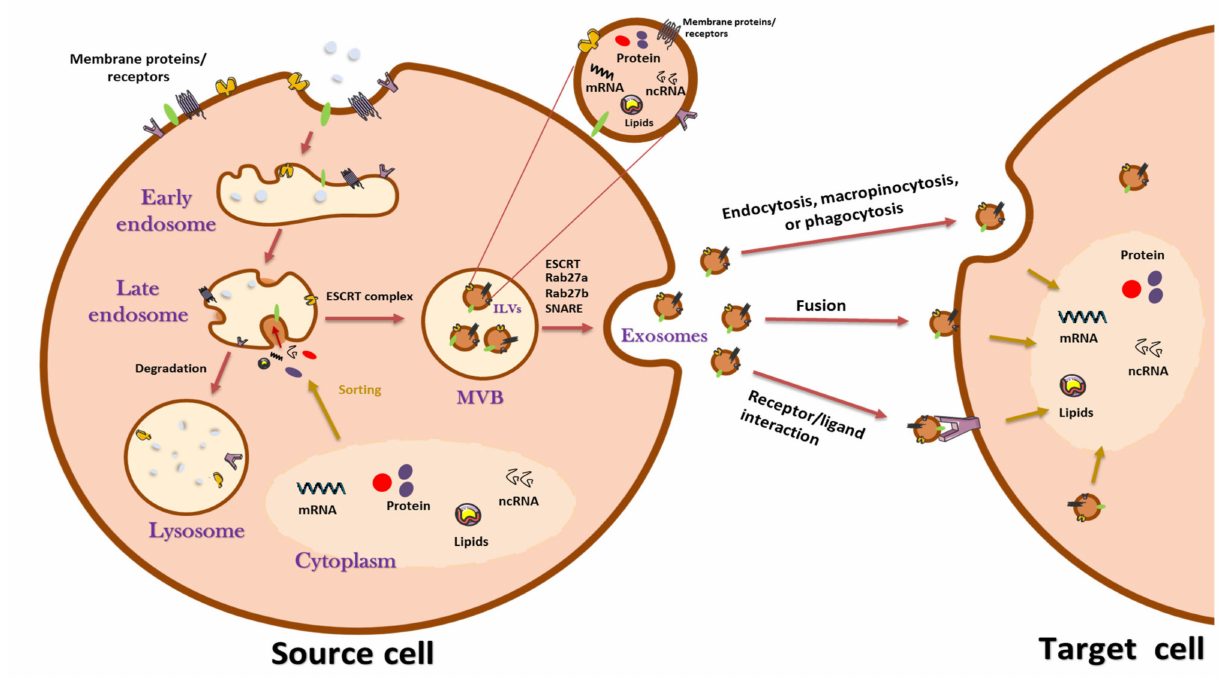
Figure 1. A schematic representation of exosome biogenesis and secretion. Exosomes are formed through the endocytic pathway. Invagination of the plasma membrane during endocytosis leads to the formation of early endosomes; exosome precursors called intraluminal vesicles (ILVs) are then formed by inward budding of late endosomes (cell RNAs, proteins, and lipid are incorporated at this step). The process of ILV biogenesis can be ESCRT-dependent or independent. Endosomes with an accumulation of ILVs are termed multivesicular bodies (MVBs); the fusion of MVBs with the plasma membrane releases the ILVs into the extracellular space by exocytosis, and these ILVs therefore become exosomes. The fusion of MVBs with the plasma membrane requires several crucial factors, such as Rab GTPases and SNARE complexes. In some instances, depending on the function and content of MVBs, they may fuse with the cell membrane and release exosomes or fuse with lysosomes for content degradation. Exosomes can directly interact with receptors on the target cell, fuse with the plasma membrane of the target cell, or enter into the target cell by endocytosis, macropinocytosis, or